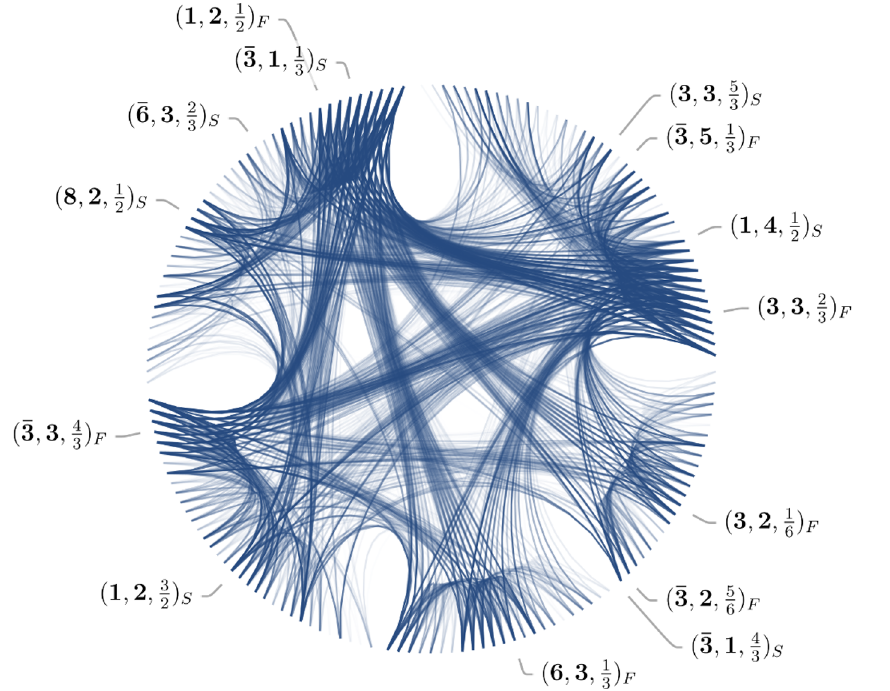
Figure 15. The graph is a representation of the connectivity between exotic fields in the neutrino- mass models. Each node represents an exotic field and edges connect fields featuring together in a neutrino-mass model. The colour is an indication of the weight of the edge, i.e. the number of times the two nodes appear in models together. The graph is clustered into roughly five communities within which there are many mutual connections. Only a handful of node labels are